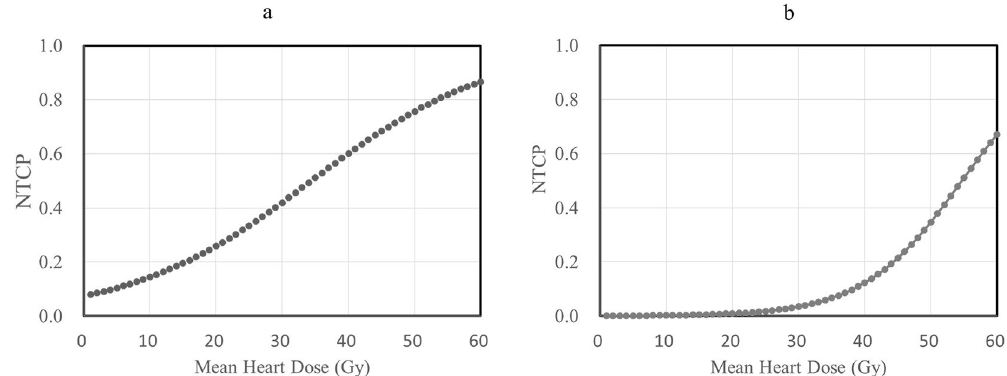
Figure 1. NTCP curves for A-PCE ( a ) and S-PCE ( b ). The NTCP curves were calculated by the logistic regression analysis derived from MHD. A-PCE, pericardial effusion in any grade; NTCP, normal tissue complicated probability; S-PCE, symptomatic pericardial effusion; MHD, mean heart